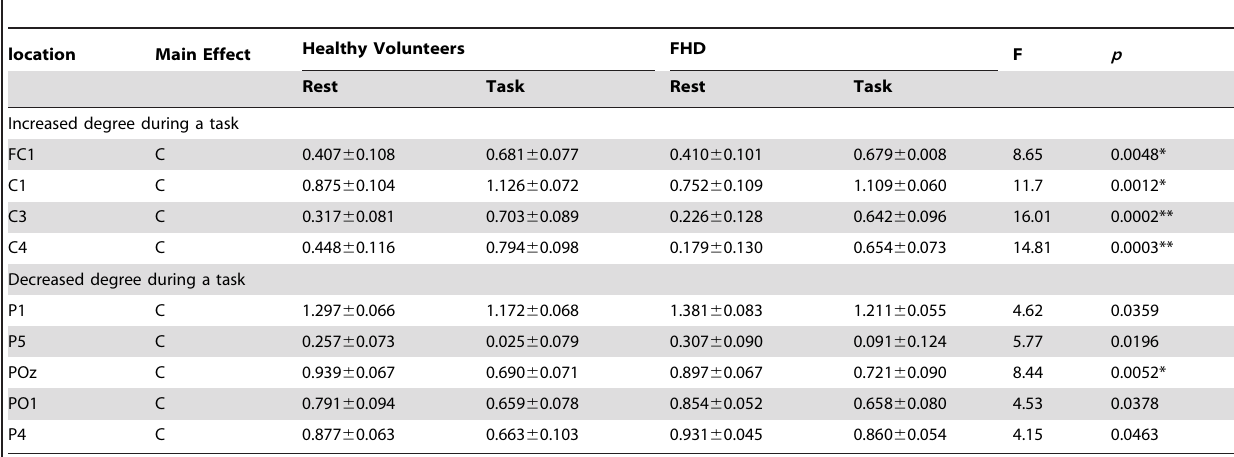
Table 4. Nodes showing significantly different degree at a cost of 0.28 corresponding to the maximal interaction in Eglob .